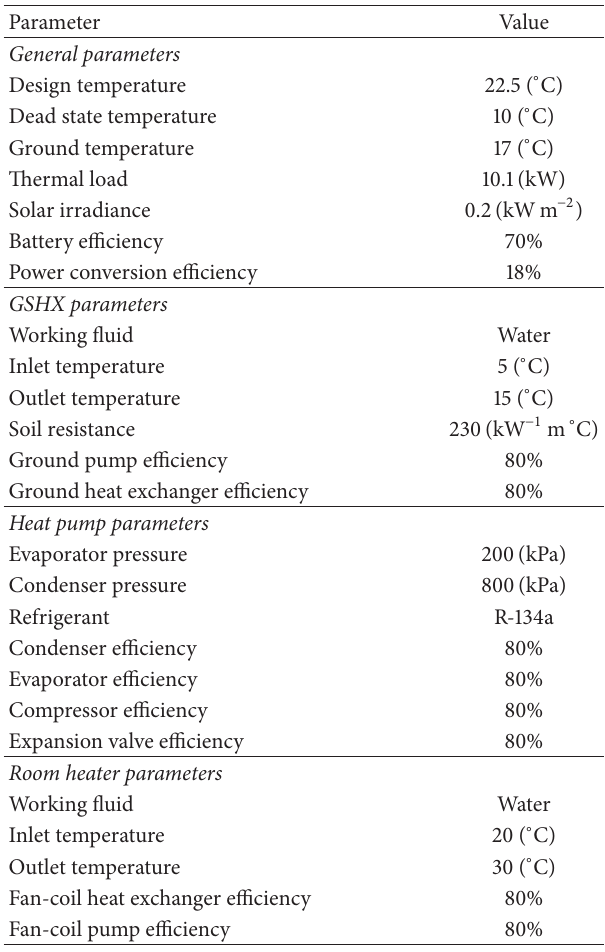
Table 1: Main assumptions for analysis (Isfahan case study, month of